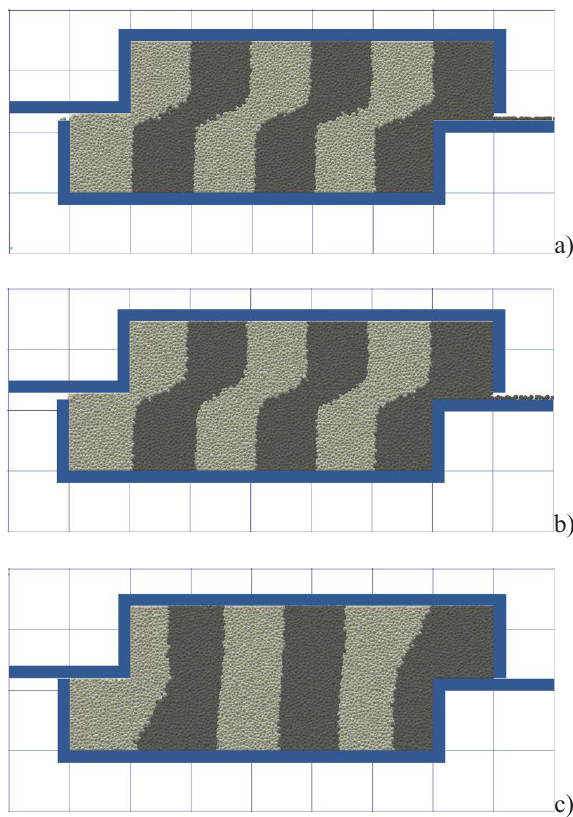
Figure 15: Internal friction angle φ u from discrete simulations of direct shear test for different vertical x load: a) σ = 50 kPa, b) σ 0 d = 0.5 50